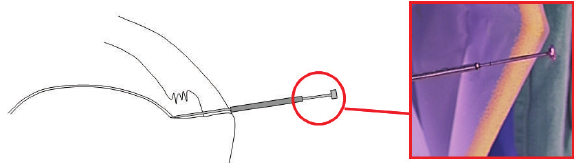
Figure 4: Schematic diagram and corresponding photo demon- strating that total tendon thickness can be read off the numbers on the distal portion of the inner metallic rod